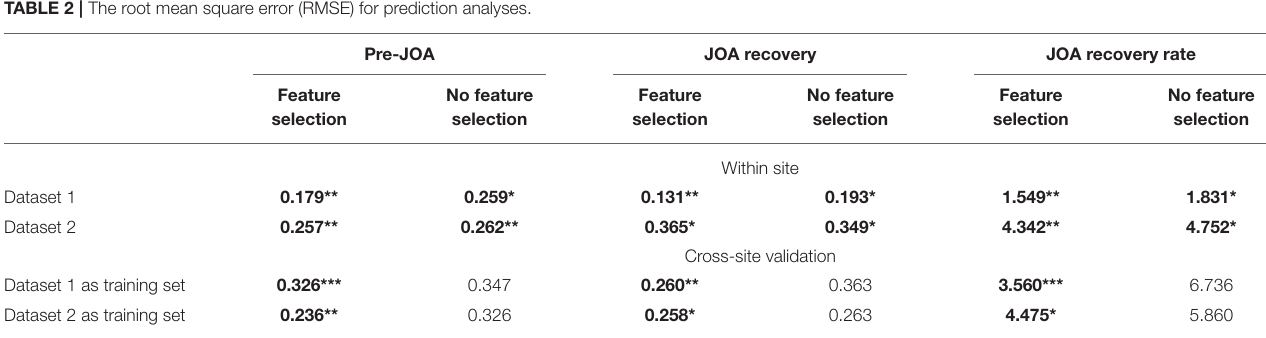
TABLE 2 | The root mean square error (RMSE) for prediction analyses.